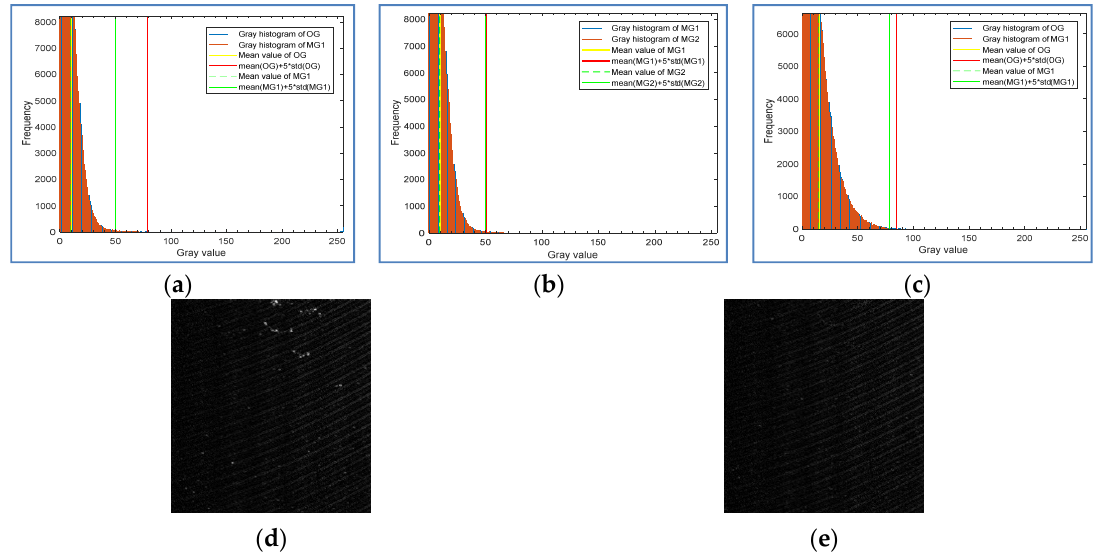
Figure 6. Histogram and statistical information of gradient graph in different iterations: ( a ) the original gradient (OG) and the mask gradient (MG1) after the first threshold segmentation; ( b ) the mask gradients MG1 and MG2 after the second threshold segmentation; ( c ) the OG and the MG1 of another test sample; ( d ) the OG; ( e ) the MG1.